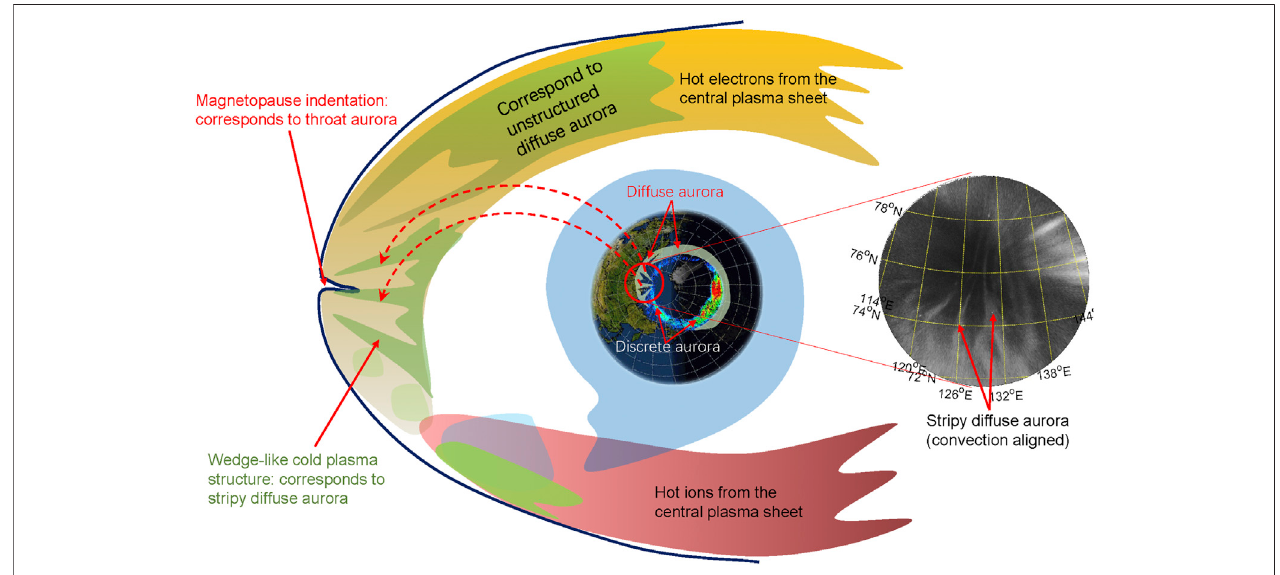
FIGURE 1| The implications ofthe statistical results about dayside diffuse aurora. The convection-aligned stripy diffuse auroraobserved near magnetic local noon is very informative (revised from Figure 15 in Han et al., 2015).